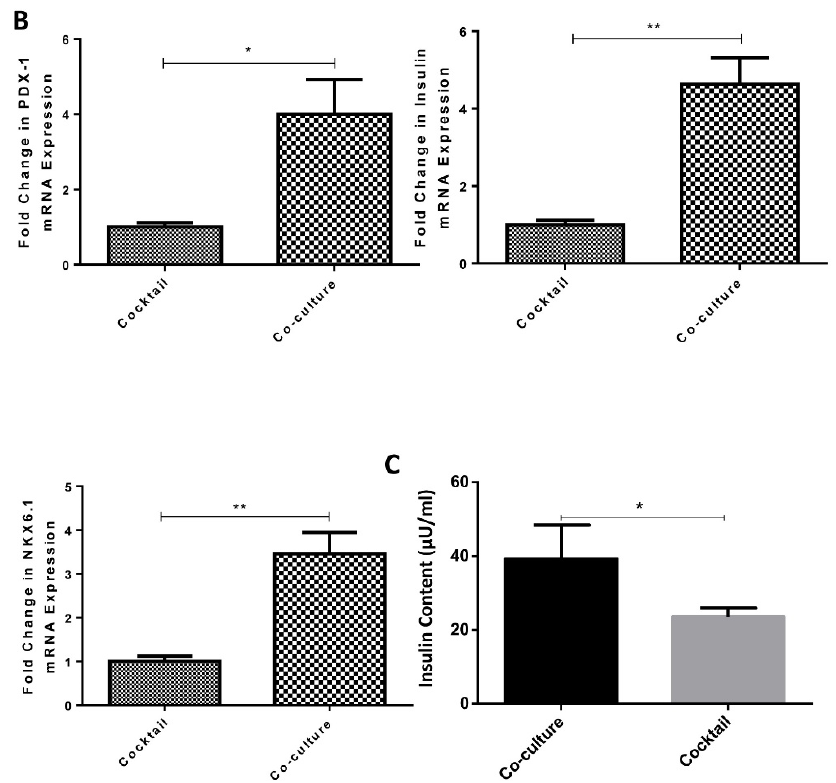
Figure 5. Promotion of the di ff erentiation of human PPCs into islet-like cell clusters (ICCs) under the MSC co-culture condition. ( A ) Gene expression of MSC co-culture derived ICC di ff erentiation markers (NGN3, NKX2.2, and NeuroD, ISL-1), and ( B ) maturation markers (PDX1, insulin, and NKX6.1) markers were measured by real-time PCR in relation with the di ff erentiation cocktail-derived ICCs. ( C ) Insulin content of ICCs was performed by an ultra-sensitive insulin ELISA kit. (n = 3 per group; * p < 0.05, ** p < 0.01, *** p < 0.001. All data are expressed as means ± SEM).